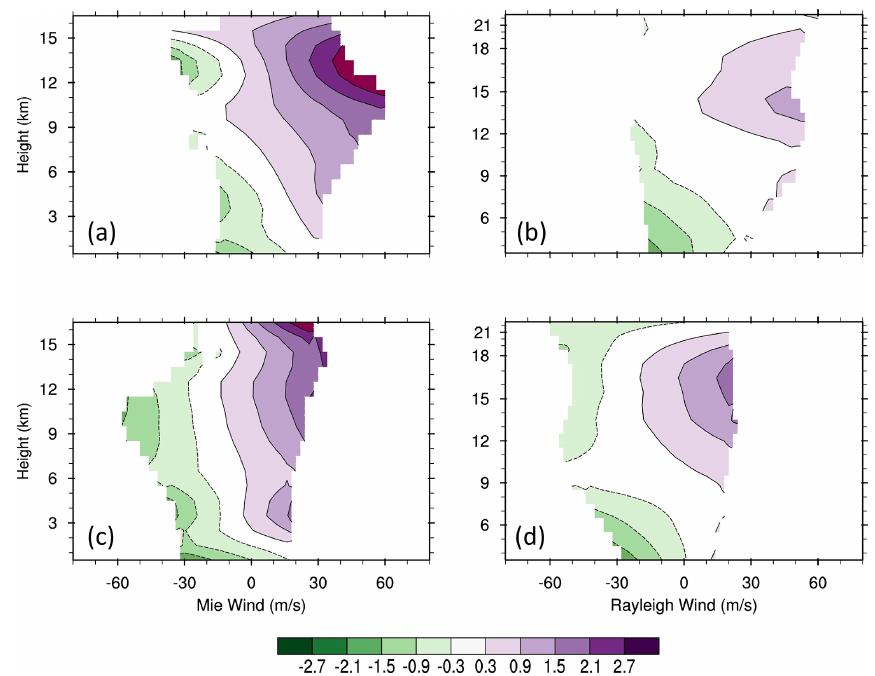
Figure 8. Vertical distributions of average TLS estimated biases (color scale; ms − 1 ) for Mie (a, c) and Rayleigh (b, d) winds as a function of observed Aeolus winds (ms − 1 ) in ascending (a, b) and descending (c, d) orbits for all latitudes. The TLS estimated biases are obtained from the TLS fits displayed in Fig.